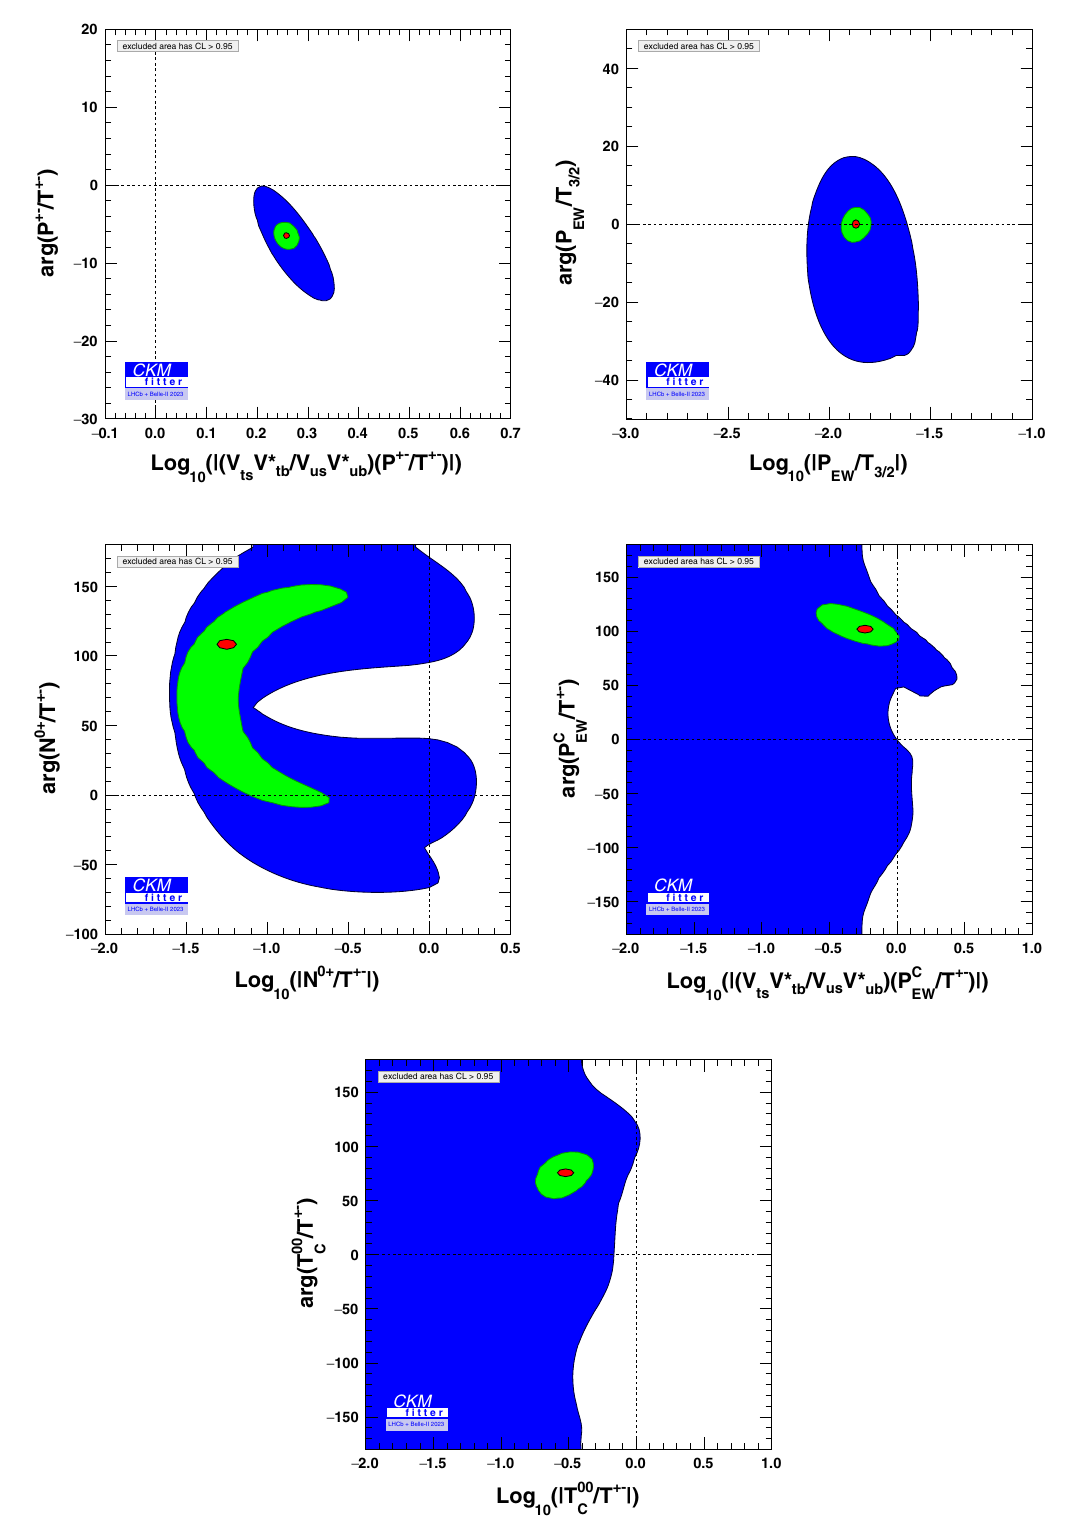
Fig. 13 The expected two-dimensional constraints on the moduli and phases of various ratios of hadronic parameters, using inputs from the first step of the prospective study, based on results from the B -factories andexpectedsensitivitiesforLHCbRun1+Run2( bluearea );andusing inputs from the second step of the prospective study, based on the com-